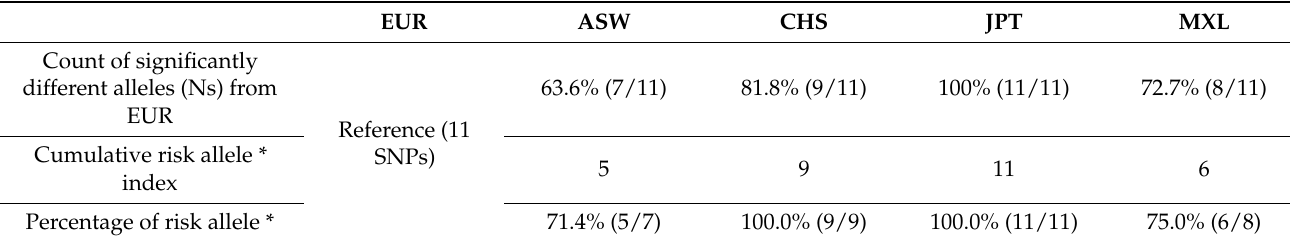
Table 4. Summary of cumulative risk alleles across major